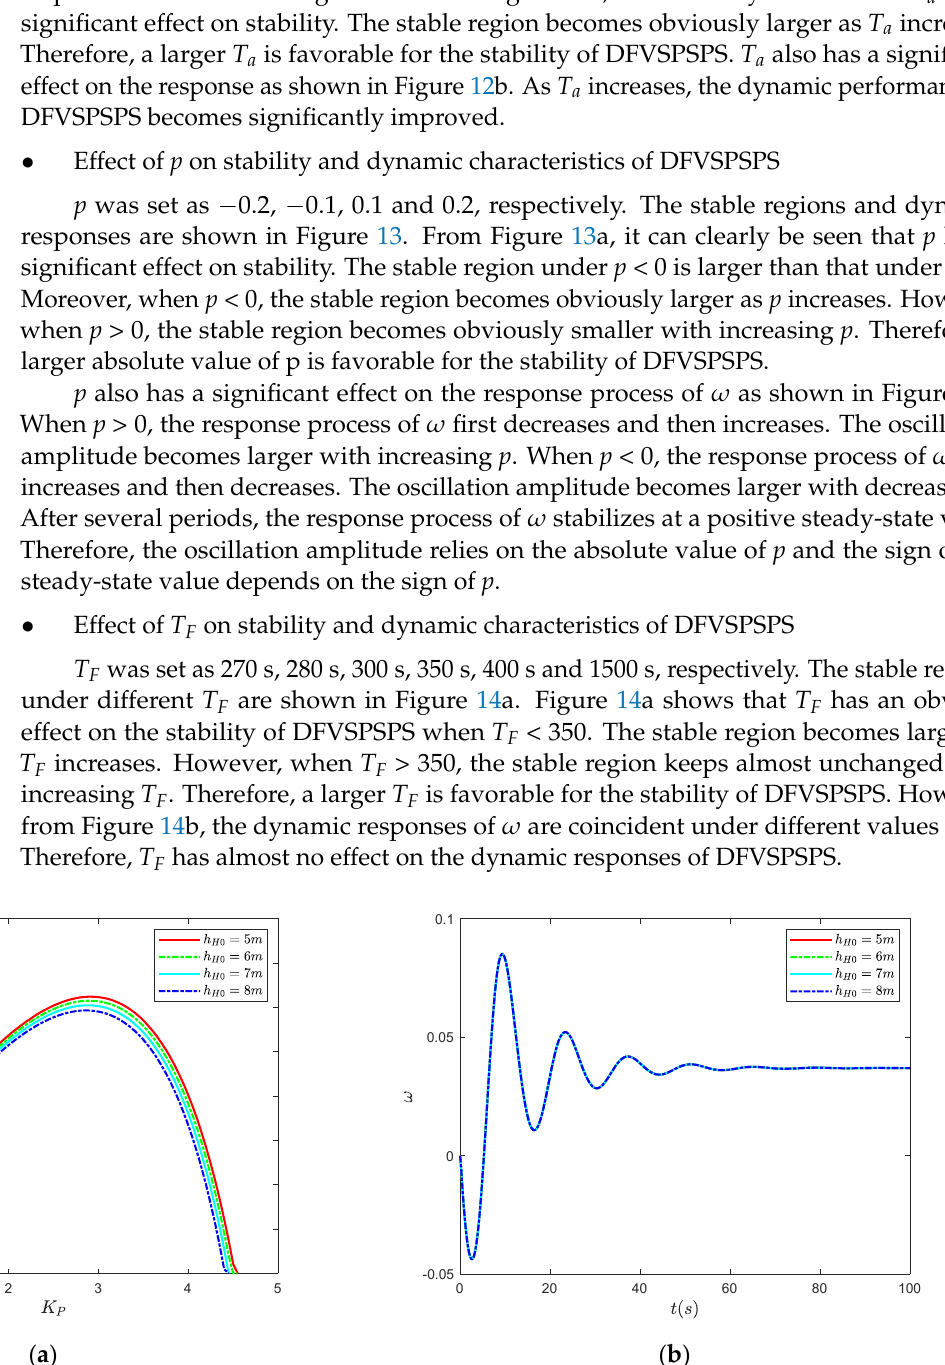
( b ) Figure 12. Effect of T a on stability and dynamic characteristics: ( a ) Stable region; ( b ) Dynamic response. ( a ) ( b ) Figure 13. Effect of p on stability and dynamic characteristics: ( a ) Stable region; ( b ) Dynamic response.